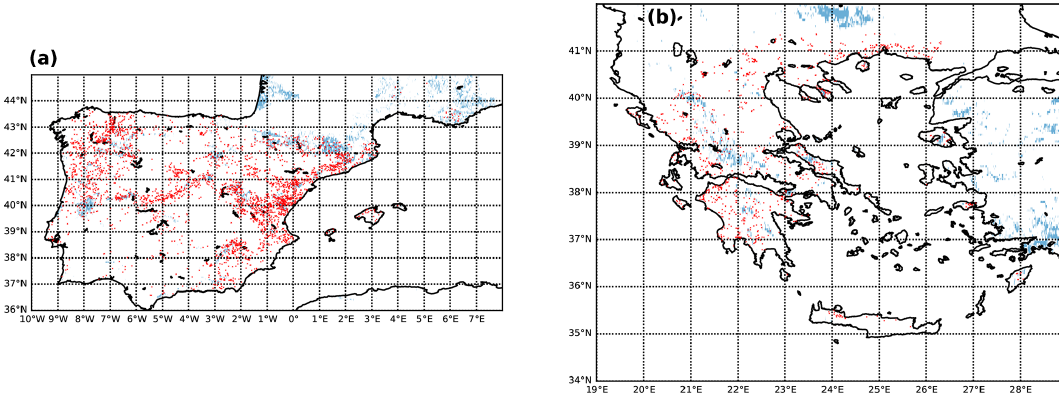
Figure 2. Coniferous and mixed forest (blue area) and LIWs (red dots) included in this study. Panel (a) shows LIWs over the Iberian Peninsula between 2009 and 2015, while panel (b) shows LIWs over Greece between 2017 and 2019. We have degraded the resolution of the vegetation map in this plot from 300m to